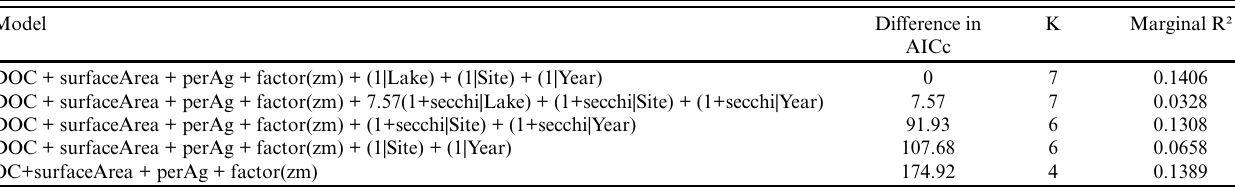
Table 2 . Candidate set of biophysical models predicting water clarity (Secchi disc depth) in the Rideau Valley, Ontario, between 2001 and 2013. (1+secchi) notation indicates a random effect that allows slope to vary as well as intercept. Model ranking using AICc and goodness of fit test (marginal R²). K = number of parameters.